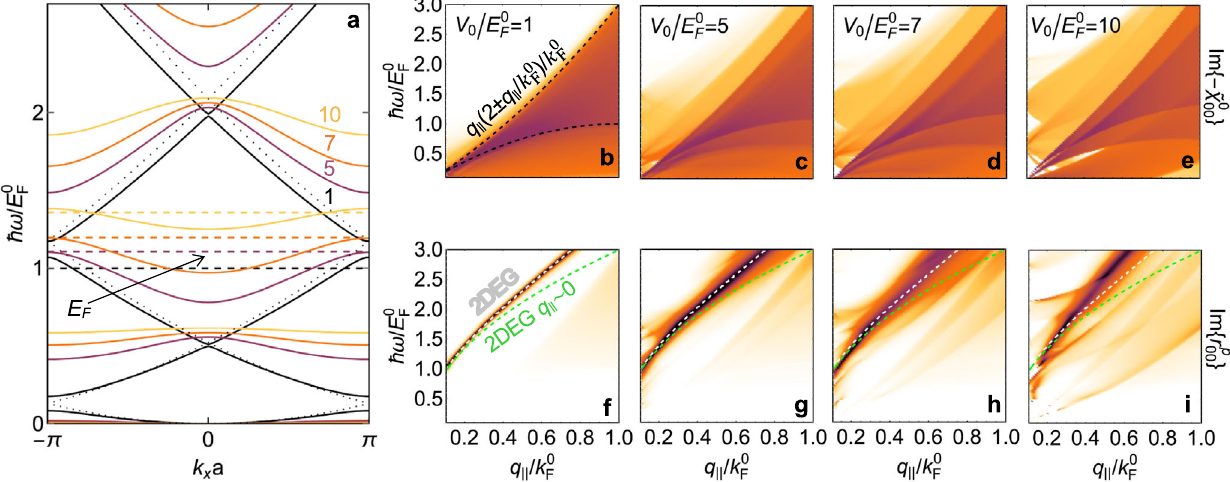
Fig. 2 | Modulation of the electronic band structure and optical response in a Q-phase material. a Electronic bands (solid curves) in the periodic patterning direction for different strengths of the normalized image potential V 0 = E 0 F (see color-matched labels), along with the corresponding normalized Fermi energies (dashed lines). Dotted curves stand for the 2D-electron-gas (2DEG) limit. Single- particleexcitationsdescribedbythe2Dnoninteractingsusceptibility ~ χ 0 00 ( b – e )and collective response resonances revealed by the loss function Im f r p 00 g ( f – i ) as a function of transferred energy ℏ ω and in-plane wave vector q ∥ = ∣ ( q x , q y ) ∣ ,